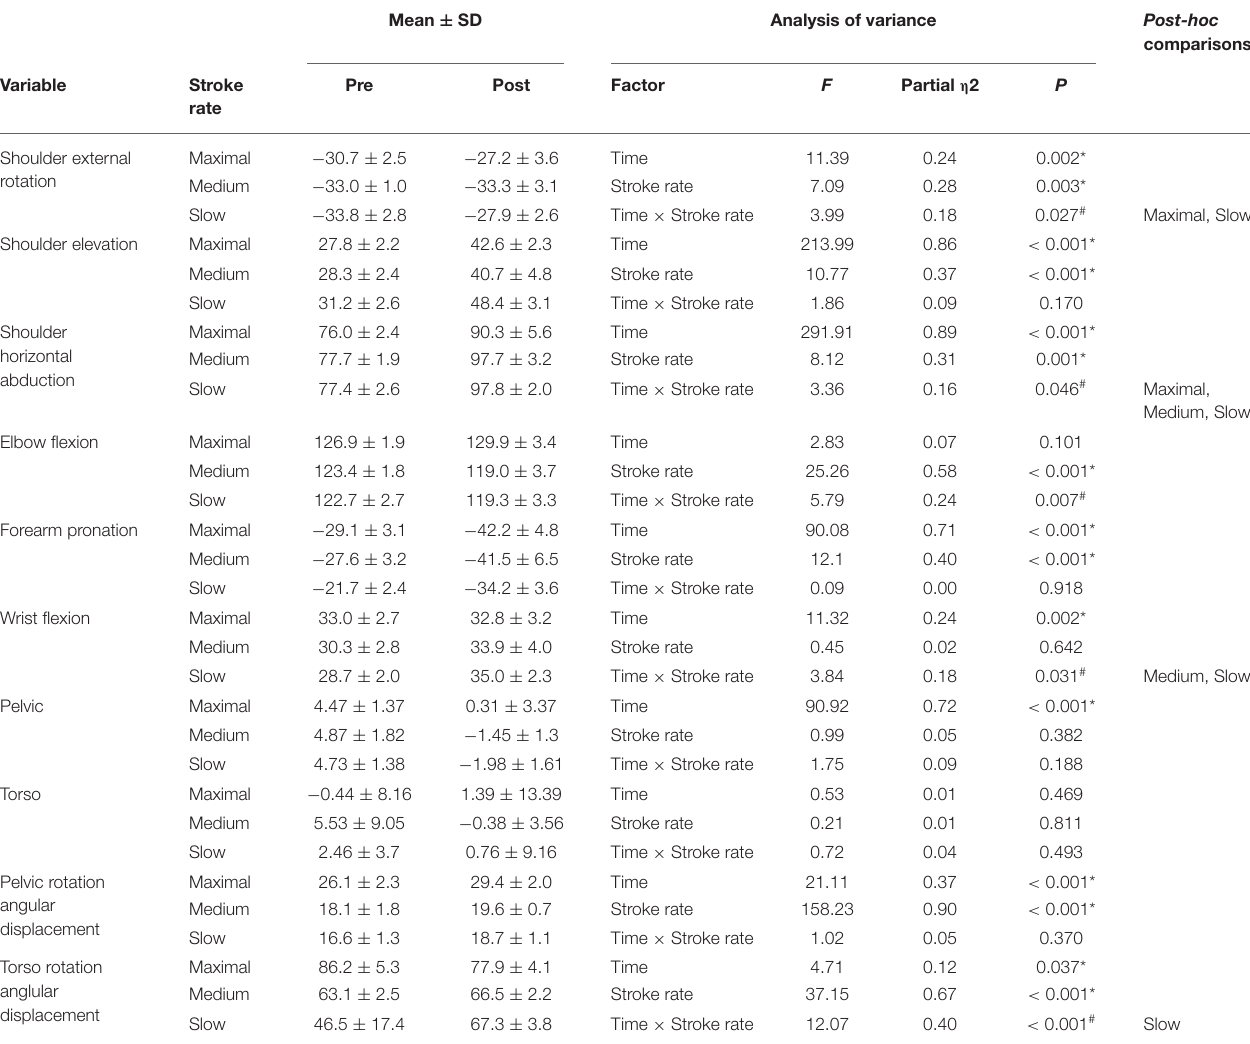
TABLE 2 | Effect of 4-week kayaking training on the joint angle at catch position, pelvic and torso rotation angular